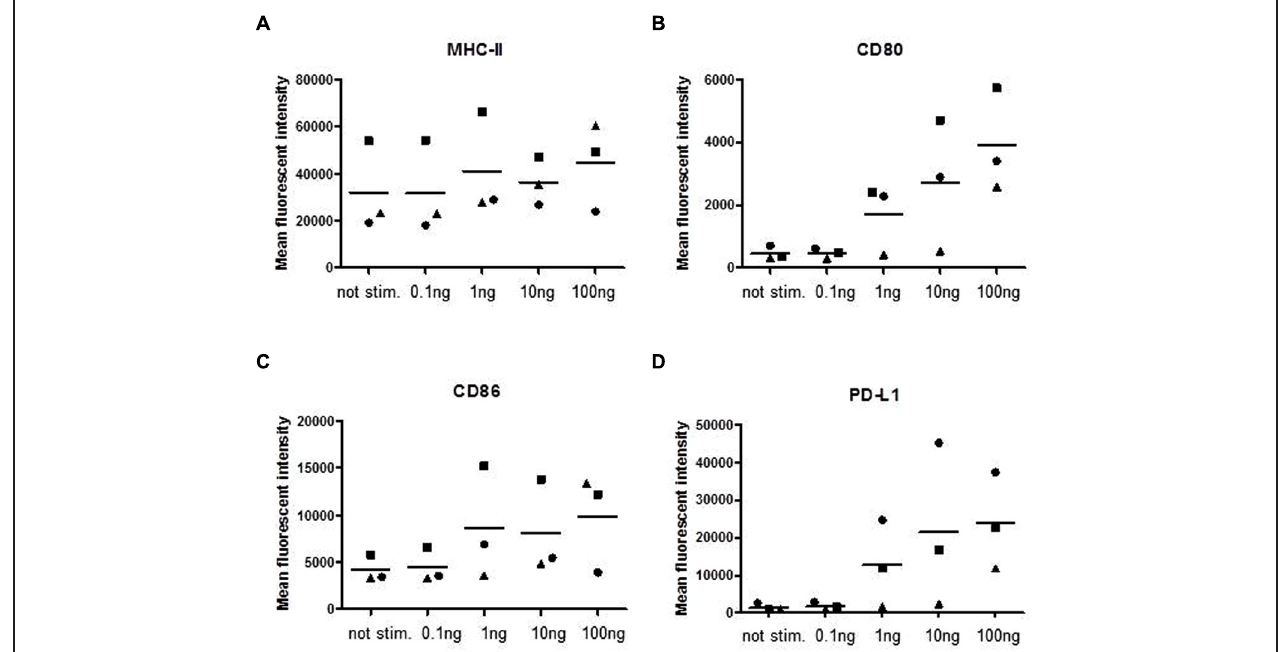
FIGURE 2 | Streptococcal pyrogenic exotoxin A- induced surface molecules. CD14 + monocytes were stimulated with increasing concentrations of SPEA as indicated. 24 h after stimulation cells were harvested and analyzed for surface markers by flow cytometry (A) MHC-II, (B) CD80, (C) CD86 and (D) PD-L1. The mean fluorescent intensity of three different experiments is shown. The line represents the mean of the experiments.